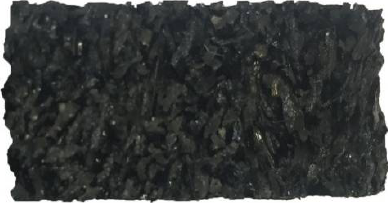
Figure 1. Regupol 6010 SP shockpad disc specimen used for test condition